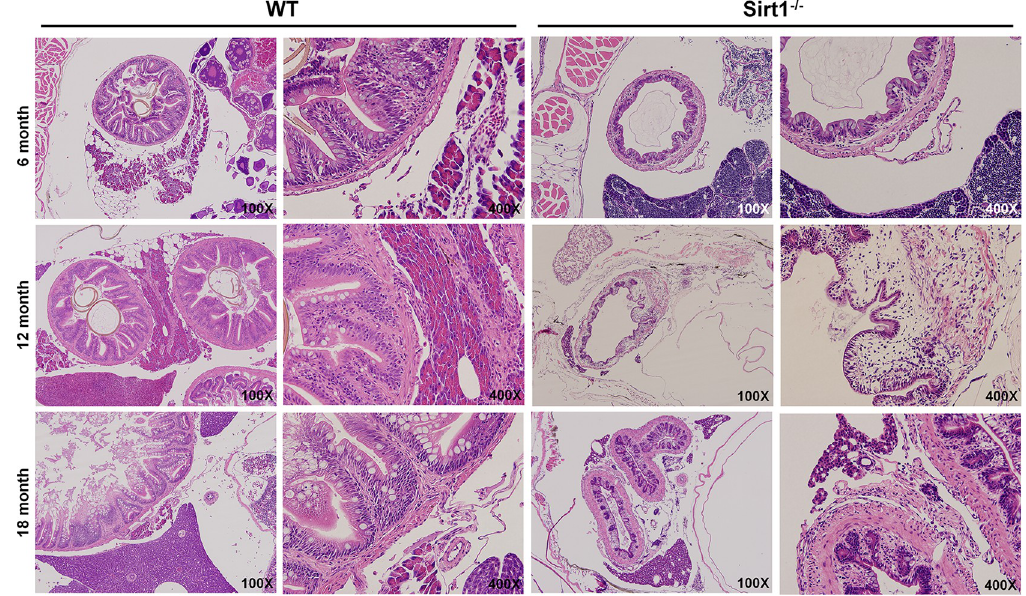
Fig 4. Microscopic observations of wildtype and Sirt1 -/- adult zebrafish. H&E images of wildtype and Sirt1 -/- zebrafish aged 6, 12, and 18 months. Sirt1 -deficiency caused intestinal atrophy and inflammatory cell infiltration.